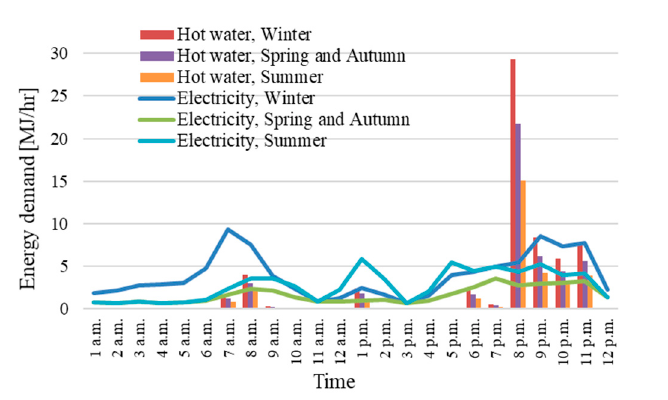
Figure 3. System boundary.